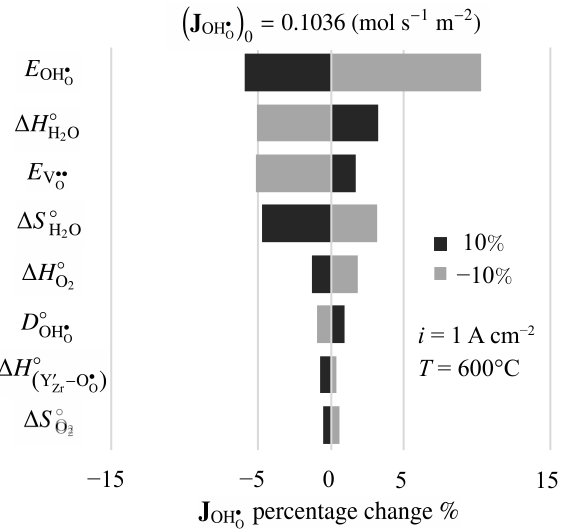
Figure 11. Sensitivity of steady-state fuel-cell proton flux to 10% changes in electro-chemo-mechanical properties. The imposed current density is i = 1 A cm − 2 .